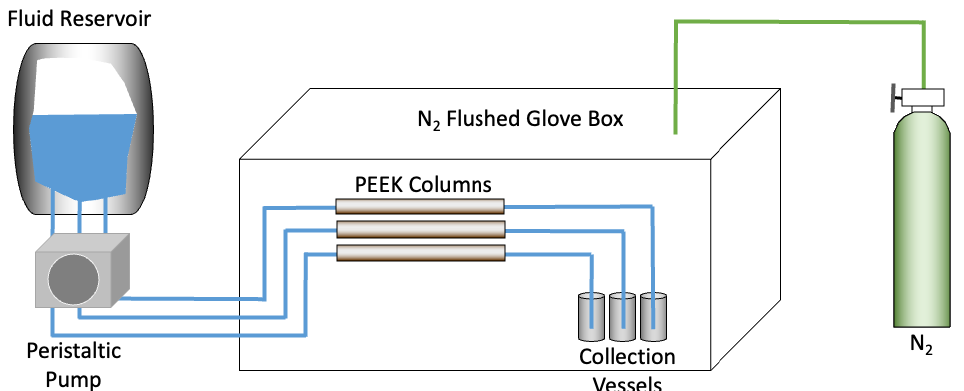
Figure 1. Schematic of column setup.